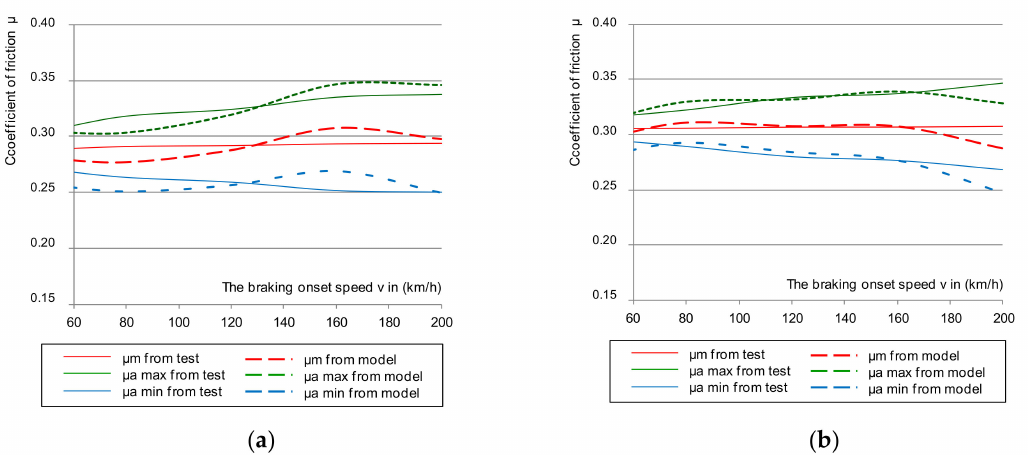
Figure 14. The changes of µ m from the tests with multiple regression model during braking on the G 3 lining with N = 25 kN, M = 5.7 t for: ( a ) smooth disc, ( b ) perforated